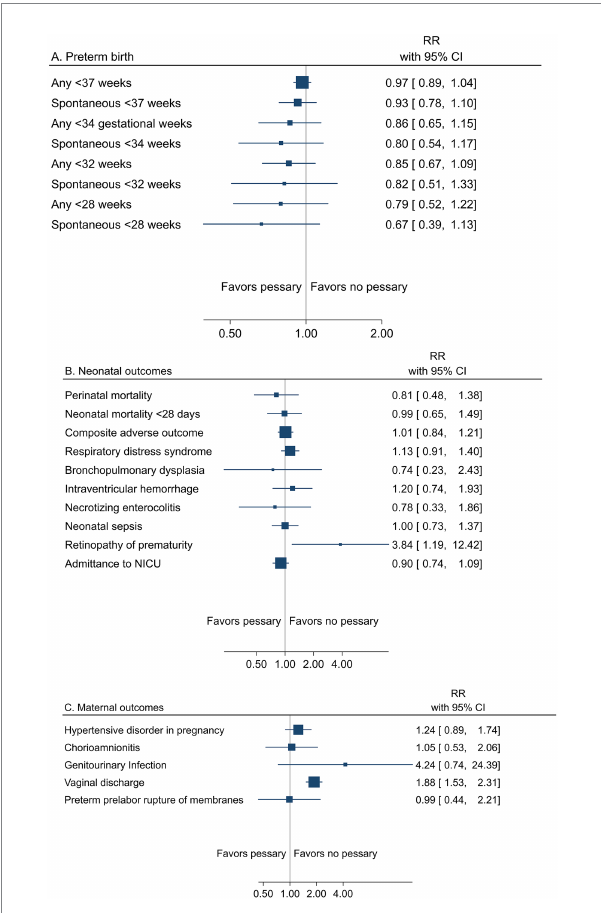
FIGURE 7 Summary graph of pooled estimates from meta-analyses comparing pessary versus no pessary in women with a multifetal pregnancy with or without additional risk factor(s) for preterm birth from trials with low risk of bias regarding (A) preterm birth, (B) neonatal, and (C) maternal